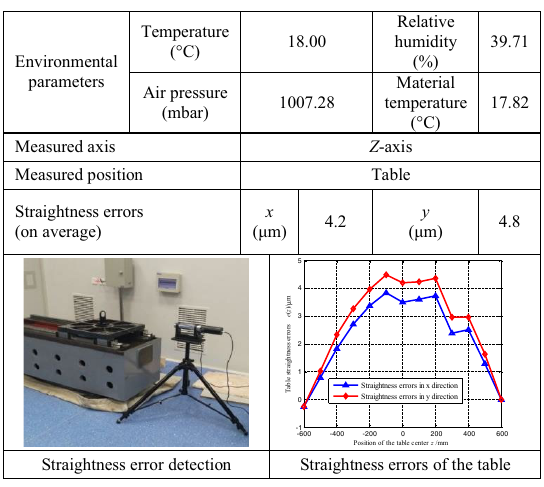
Table 5 Straightness errors of the table